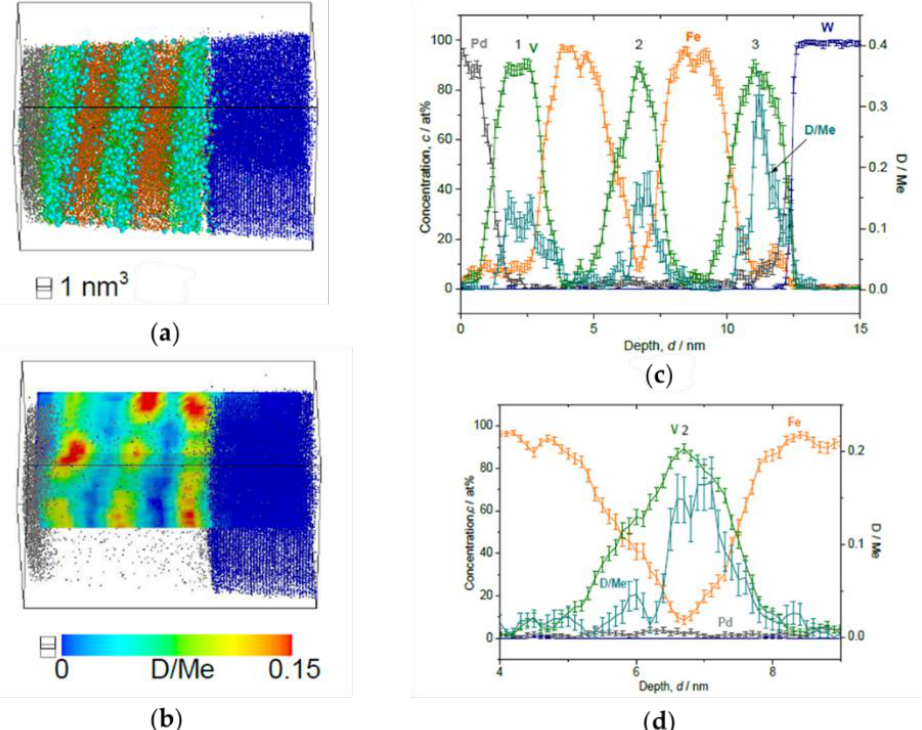
Figure 10. Reconstructed volume of Fe/V multi-layer (12 nm × 12 nm × 20 nm), loaded with D 2 2 Pa, analyzed at 30 K. ( a ) The whole volume of reconstruction (grey: Pd, green: V, orange: Fe, blue: W, light blue: D). ( b ) Iso-concentration map of D concentration ( c D = 0.15 D/Me) from the same reconstruction in ( a ). ( c ) Depth concentration profile from 5 nm φ cylinder volume. Notably high c D in the 3rd V layer is observed. ( d ) Magnified plot of the 2nd V layer. The c D shows an asymmetric profile.